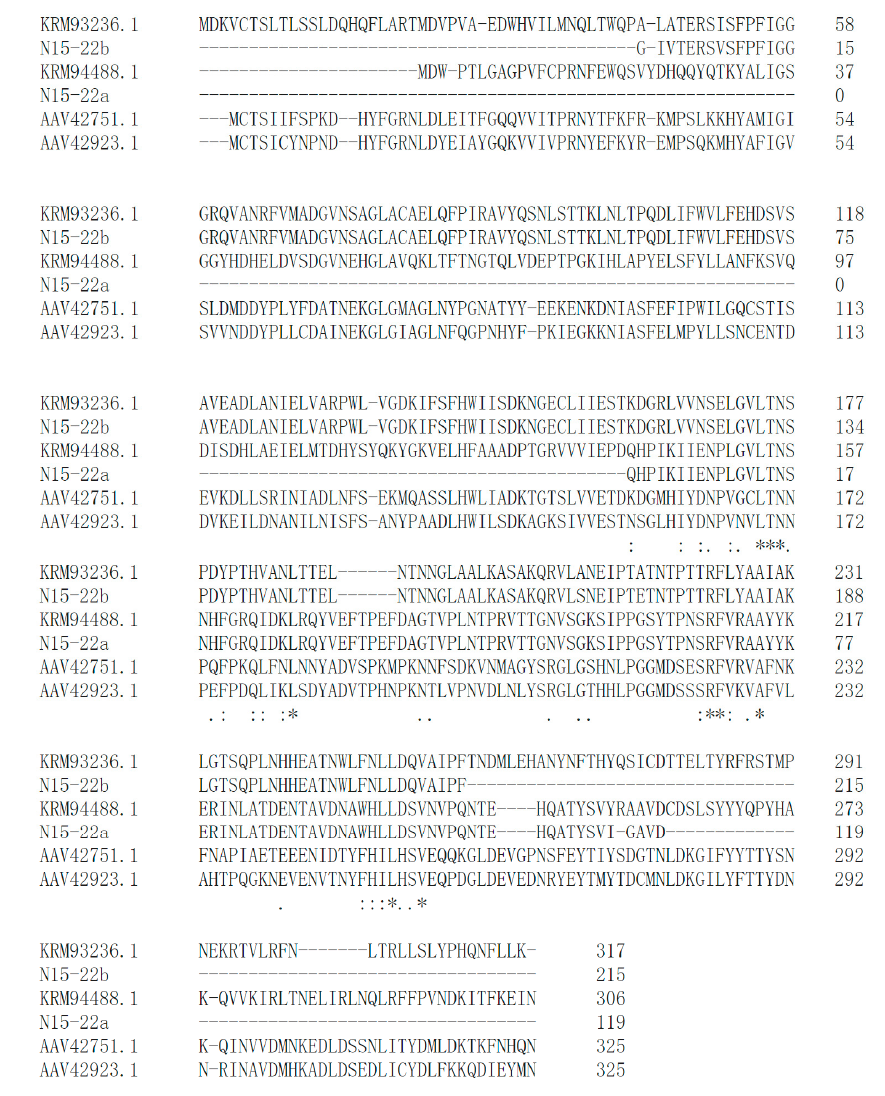
Figure 2. Amino acid sequence alignment of two putative BSHs, N15-22a and N15-22b, identified in N15-22 and the reference BSHs from NCBI. The closest reference BSHs were KRM94488.1 and KRM93236.1 from Lactobacillus senioris DSM 24302, while AAV42751.1 and AAV42923.1 were two functional BSHs reported from Lactobacillus acidophilus [45]. The identical amino acids are indicated by asterisks; the conservative and semi conservative amino acids are indicated by two dots and one dot, respectively. N in the LTN-conserved motif and R in the RF-conserved motif are the previously described conserved active-site